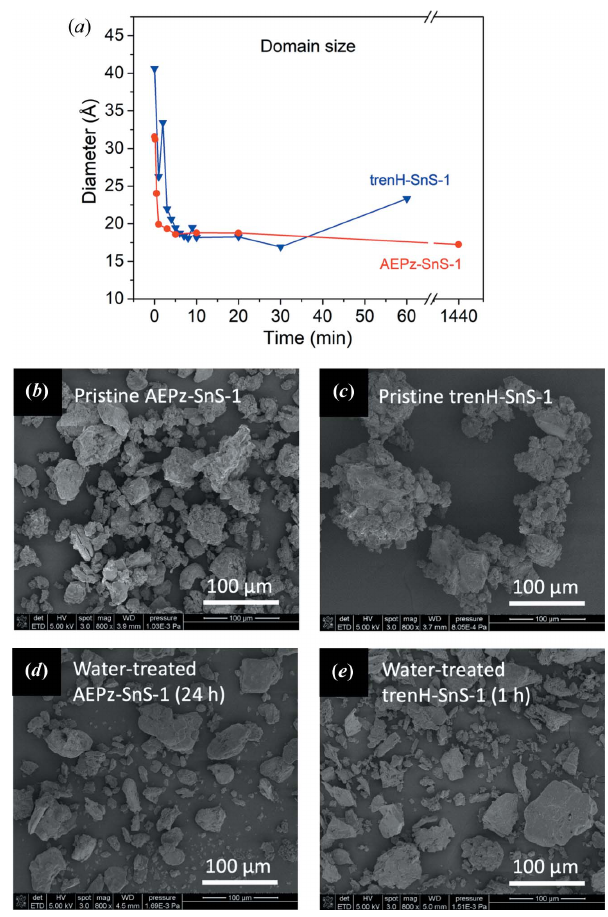
Figure 4 ( a ) Spherical domain size obtained by refinement of tren-SnS-1 and AEPz-SnS-1 PDF data displayed as a function of time in water. The lines are guides to the eyes. SEM images of ( b ) pristine AEPz-SnS-1, ( c ) pristine trenH-SnS-1, ( d ) water-treated AEPz-SnS-1 (24 h) and ( e ) water- treated trenH-SnS-1 (1